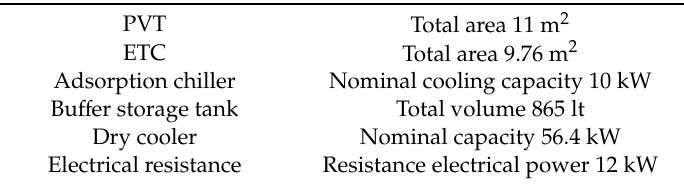
Table 1. Main components of the examined solar system.